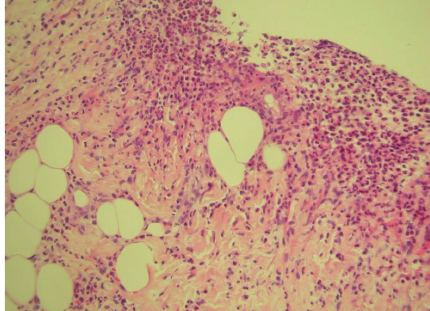
Figure 2: Adenseneutrophilic infiltrateintheupper dermis around thedermalbloodvessels,inthedeeperdermisandthesubcutaneous fat (haematoxylin and eosin; original magnification × 25).